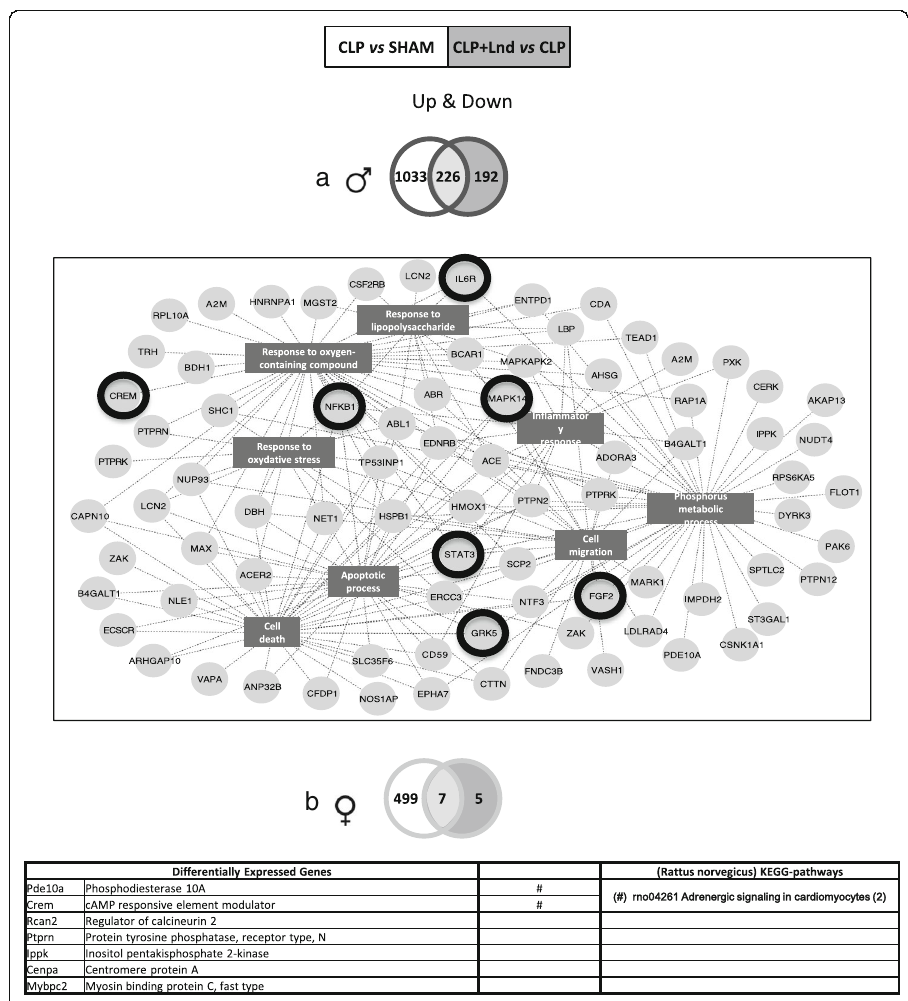
Fig. 2 Biological processes associated with up-regulated genes after cecal ligation and puncture and back- regulated by landiolol infusion. a Venn diagram associated with the 1259 up-regulated genes in CLP group and the 418 down-regulated genes in CLP plus landiolol group in males. The 226 common genes represent regulated genes with a characteristic V form, up-regulated in sepsis and back-regulated by landiolol infusion. From these 226 common genes, a gene ontology analysis with the DAVID Database revealed significant biological processes (P-Benjamini < 0.05). A gene network diagram was performed using Cytoscape integrating the 226 genes (light grey circles) with their associated biological processes (dark grey rectangles). Genes associated with the JAK/STAT pathway, IL6R and STAT, with the PI3K/AKT and focal adhesion pathways, FGF2 and NF κ B1, and with the mitogen-activated protein kinase and tumour necrosis factor- α pathways, cyclic adenosine monophosphate responsive element modulator and MAPK14 and GRK5, are surrounded by a black circle. b Venn diagram associated with the 506 up-regulated genes in CLP group and the 12 down-regulated genes in CLP plus landiolol group in females. Note that only 12 genes were down-regulated in CLP plus landiolol condition and that only seven of them were back-regulated. No significant biological processes were found associated to these seven genes presented in the table; two genes are members of the adrenergic signalling in the cardiomyocyte KEGG-pathway and the others are isolated genes. CLP cecal ligation and puncture, CLP + Lnd CLP plus